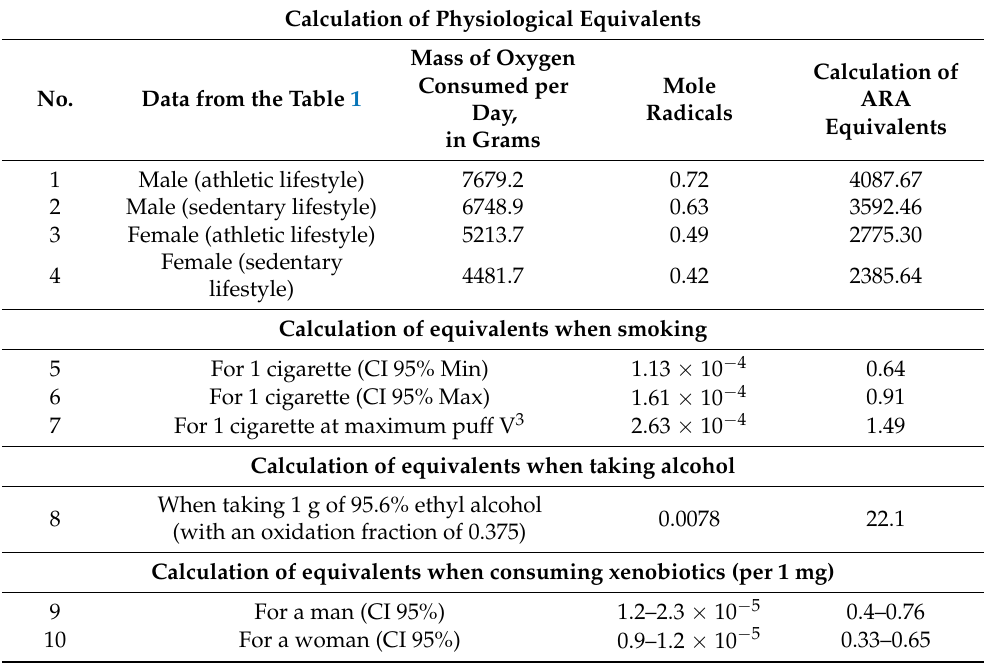
Table 3. Summary table of calculating P (m, o) and ARA equivalents for the proposed algorithm. Calculation of Physiological